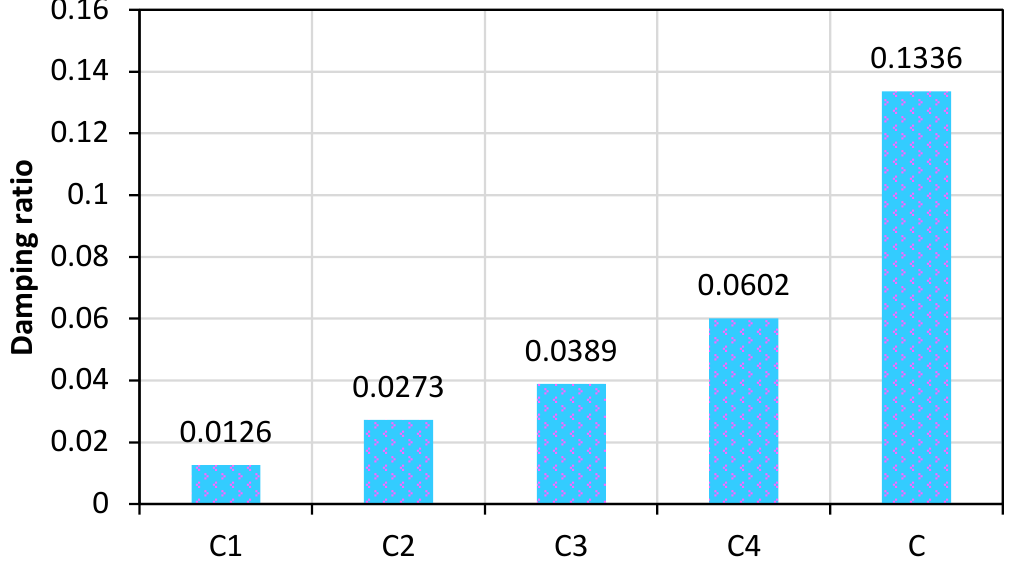
Figure 29. Damping ratio for the specimens.